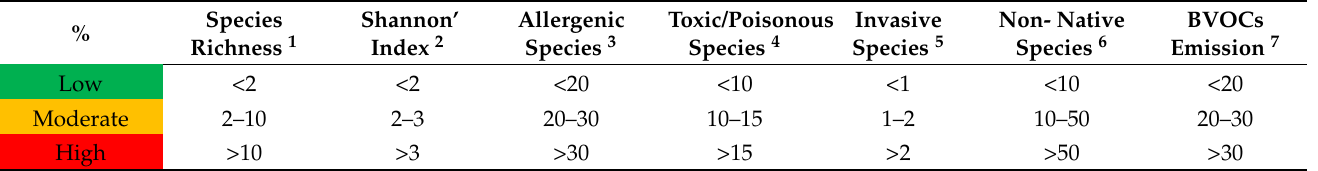
Table 1. Values to assign to the indicators of the biodiversity